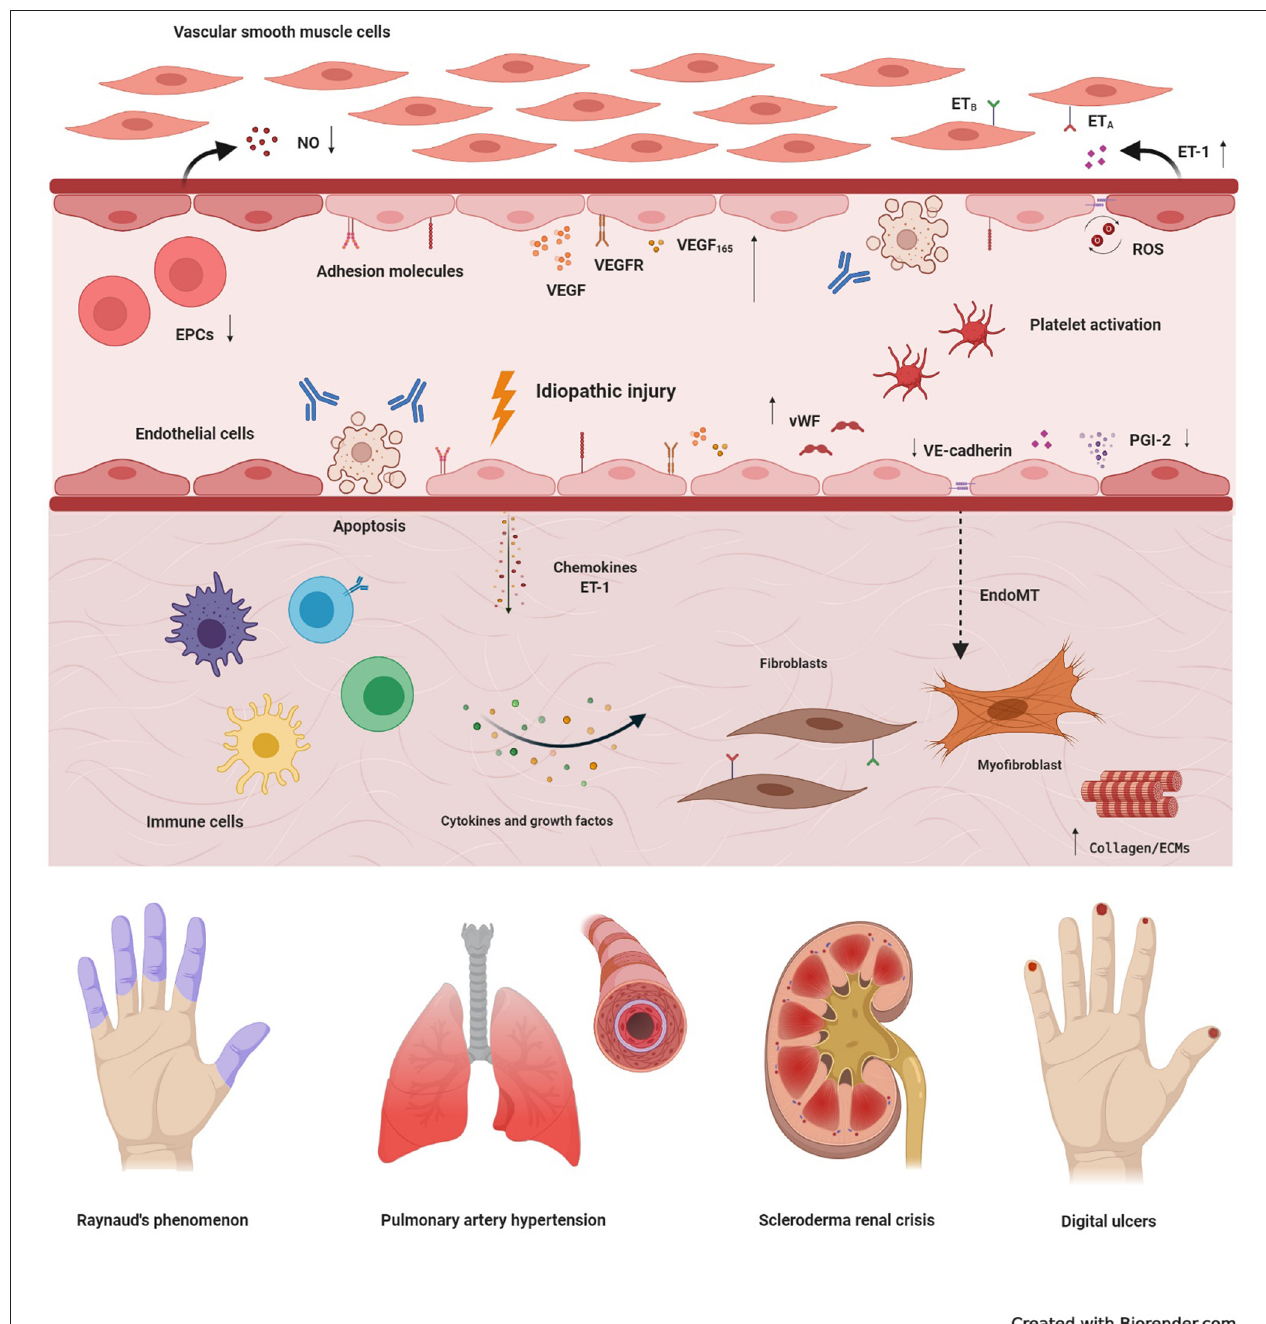
FIGURE 1 | Basic mechanisms of systemic sclerosis-related vasculopathy. Vascular injury is considered an initial event in the development of systemic sclerosis (SSc), and may be triggered by multiple factors, including autoantibodies, infectious agents, reactive oxygen species (ROS), or idiopathic stimuli. In the early stages of disease, vascular damage leads to activation of endothelial cells (ECs), with expression of adhesion molecules, production of chemokines, von Willebrand factor (vWF) and vasoconstrictor agents, such as endothelin-1 (ET-1). Molecules produced by the injured endothelium recruit immune cells, that generate a perivascular infiltrate. Prolonged inflammation leads to tissue fibrosis, with excessive activation of resident fibroblasts that transdifferentiate into myofibroblasts, the main cell type involved in excessive collagen production and other extracellular matrix components (ECMs). Myofibroblasts are also originated through the endothelial-to-mesenchymal transition (EndoMT). Dysfunction of endothelial progenitor cells (EPCs), antibody-induced ECs apoptosis, persistent platelet activation, decreased production of vasodilatory nitric oxide (NO) and prostaglandin I-2 (PGI-2), synthetized by ECs, also participate in the pathogenesis of SSc-vasculopathy. In addition, compensatory mechanisms of vasculogenesis and angiogenesis, including vascular endothelial growth factor (VEGF) and its receptor (VEGFR), are dysregulated and ineffective. High